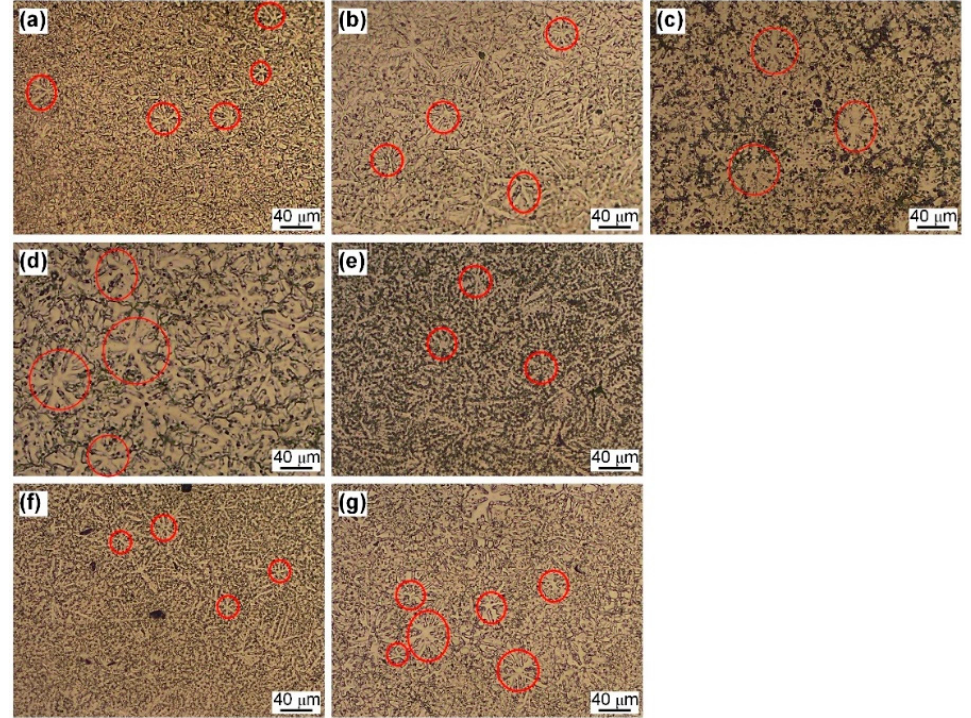
Figure 9. Weld microstructure characteristics at the center of the wide upper arc zone; ( a – c ) laser power at 3, 4, and 5 kW under given welding speed of 1.8 m/min and welding current of 100 A, ( d , e ) welding speed at 1.2 and 2.4 m/min under given laser power of 4 kW and welding current of 100 A and ( f , g ) welding current at 50 and 150 A under given laser power of 4 kW and welding speed of 1.8 m/min.